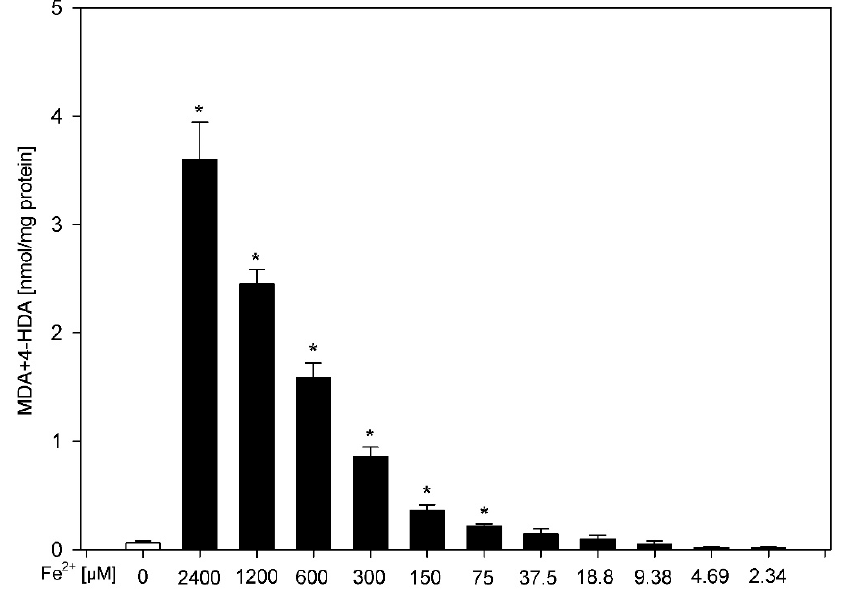
Figure 1. Concentration of malondialdehyde + 4-hydroxyalkenals (MDA + 4-HDA) in skin homogenates. Homogenates were incubated in the presence of FeSO 4 (2400, 1200, 600, 300, 150, 75, 37.5, 18.75, 9.375, 4.6875 and 2.34375 µ M) plus H 2 O 2 (5 mM). Data are expressed as the amount of MDA + 4-HDA (nmol) per mg of protein. Bars represent the mean ± SE of three independent experiments run in duplicate. * p < 0.05 vs. control (white